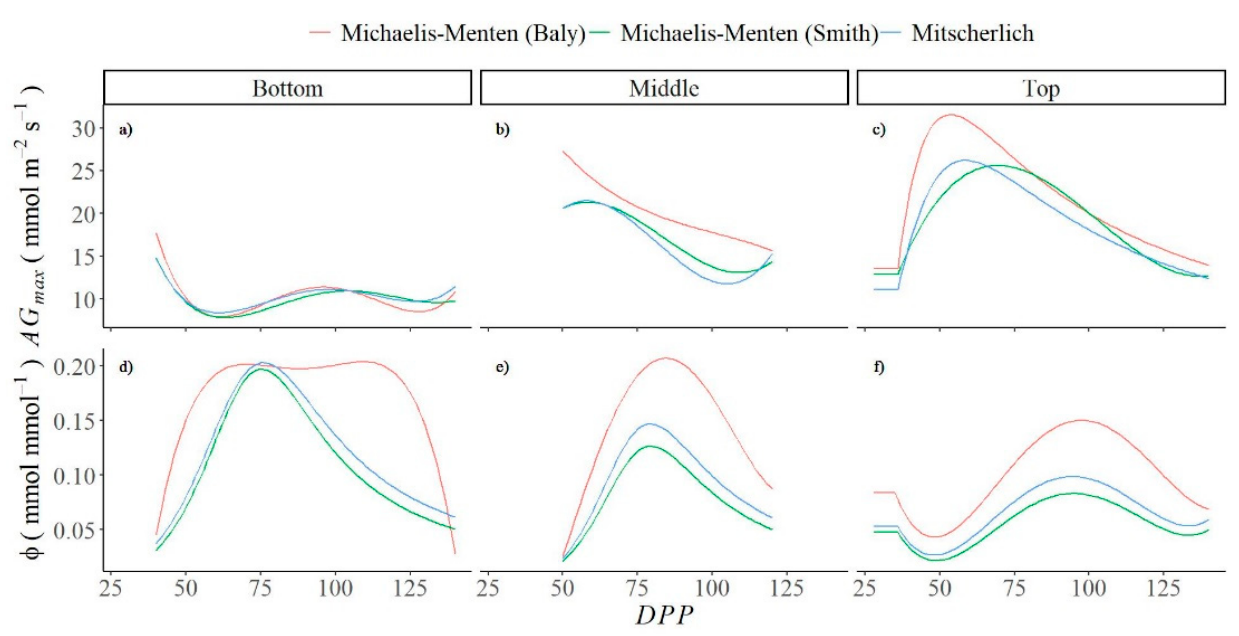
Figure 5. Parameters of light-saturated gross photosynthetic rate ( A gmax ) and quantum yield of assimilation ( Φ ) for the topmost unshaded leaves (( c , f ), respectively), middle stratum leaves(( b , e ), respectively), and the bottommost shaded leaves (( a , d ), respectively) of potato ( Solanum Tuberosum L. Var. Diacol capiro) calculated by the rectangular hyperbola Michaelis—Menten type function, Smith [47] and Baly [46], and by an exponential Mitscherlich function [49].